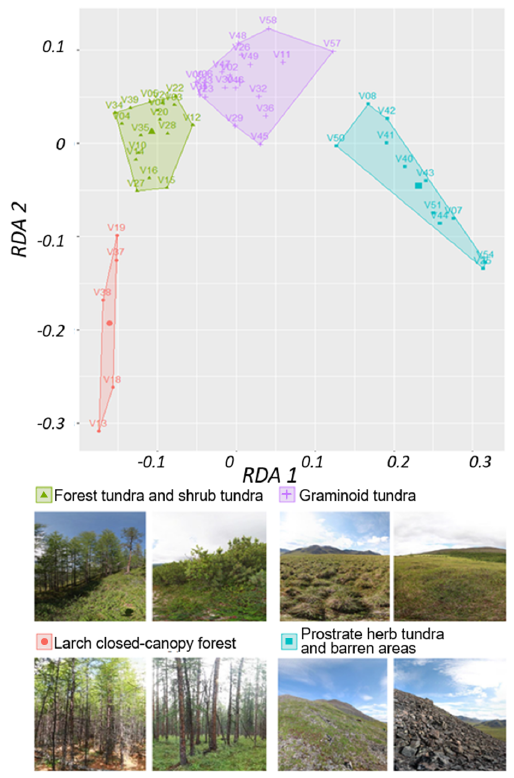
Figure B2. k -means classes based on two redundancy analysis (RDA) axes using the normalised difference vegetation index (NDVI), nor- malised difference water index (NDWI), and normalised difference snow index (NDSI) as predictors. Images: extracts from 360 × 180 ◦ panoramic images, Stefan Kruse (figure in Shevtsova et al., 2020a).